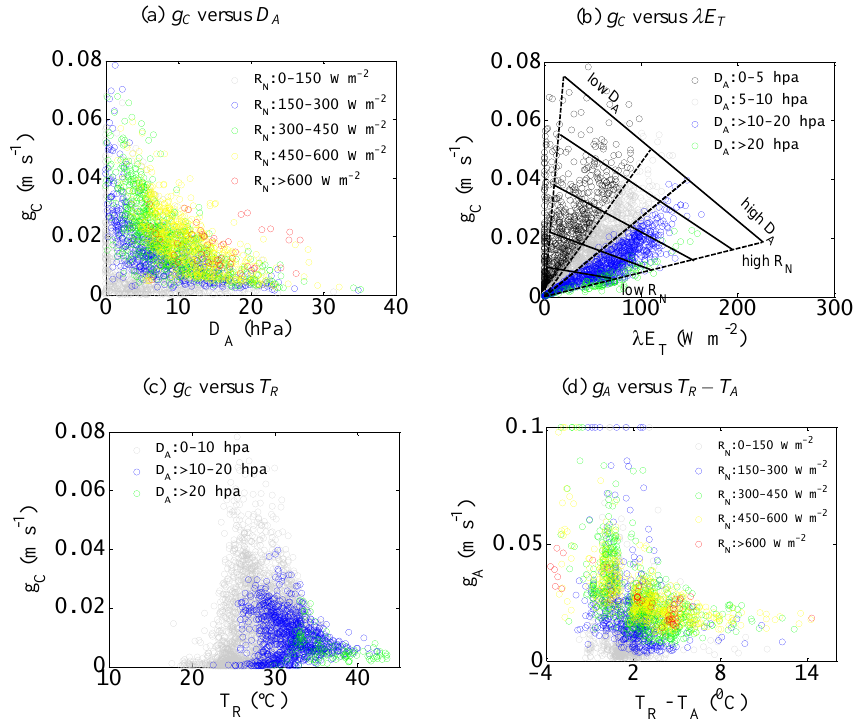
Figure 8. (a) Response of retrieved g C to atmospheric vapor pressure deficit ( D A ) for different classes of net radiation ( R N ), (b) response of retrieved g C to transpiration for different classes of D A , (c) response of retrieved g C to radiometric surface temperature ( T R ) for different classes D A , and (d) relationship between retrieved g A and radiometric surface temperature and air temperature difference ( T R − T A ) in the Amazon Basin (LBA tower